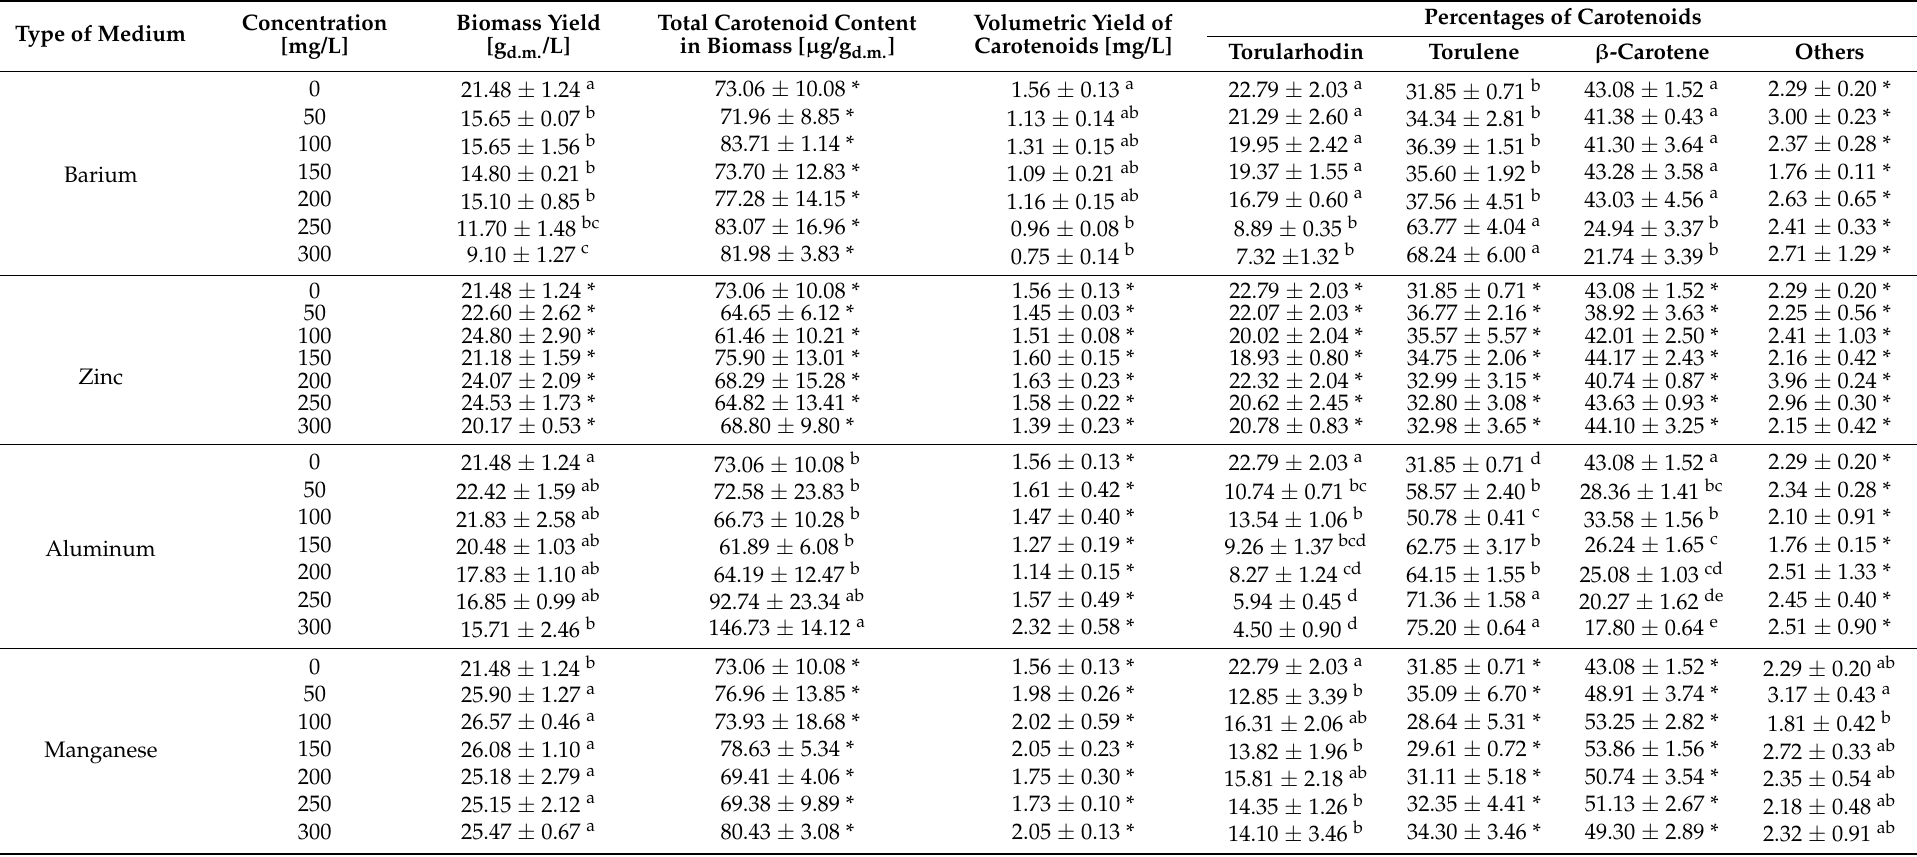
Table 3. Biomass yield and content and profile of carotenoids after 120 h of cultivation in media enriched with selected